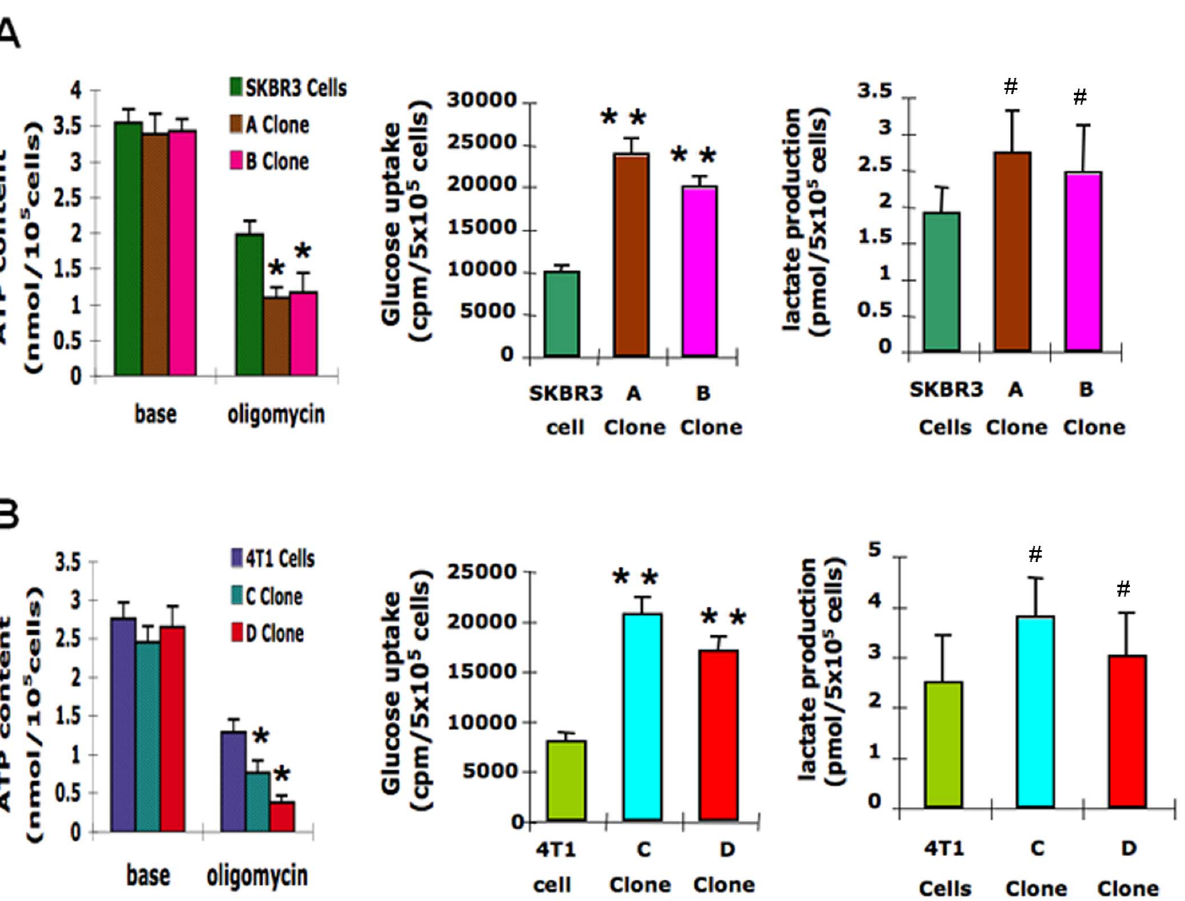
Figure 1. Biochemical characterization of mitochondrial dysfunction of both clones of breast cancer cells. A, Comparison of ATP synthase (left), glucose uptake (middle), and lactate production (right) in SKBR3 cells. *P , 0.01 vs SKBR3 cells, **P , 0.05 vs SKBR3 cells, # P , 0.05 vs SKBR3 cells (n=3). B, Comparison of ATP synthase (left), glucose uptake (middle), and lactate production (right) in 4T1 cells. *P , 0.05 vs 4T1 cells, **P , 0.01 vs 4T1 cells, # P , 0.05 vs 4T1 cells (n=3).